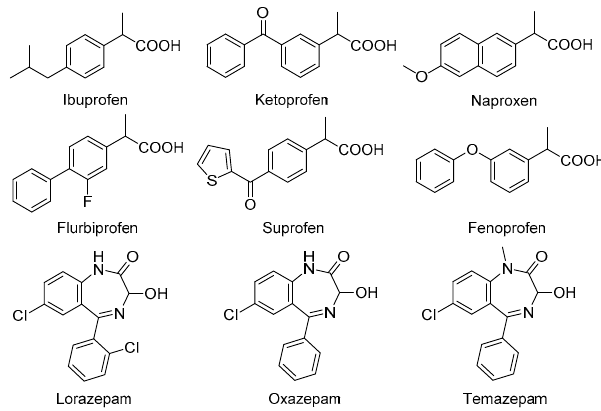
Figure 7. Structures of the tested non-steroidal anti-inflammatory drugs (NSAIDs) and 3-hydroxy- benzodiazepine drugs.